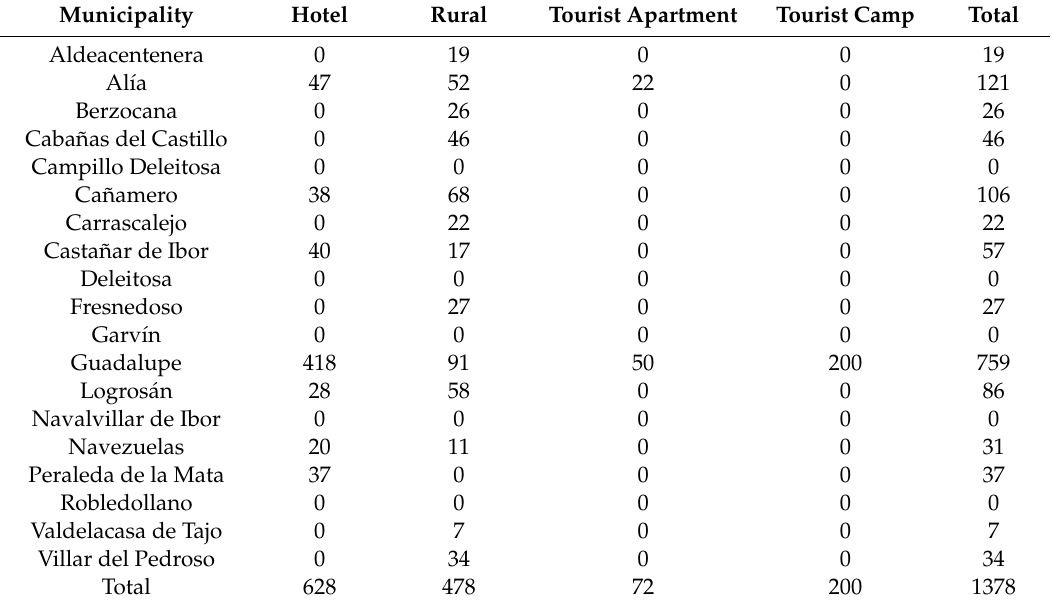
Table 2. Distribution of beds according to accommodation type